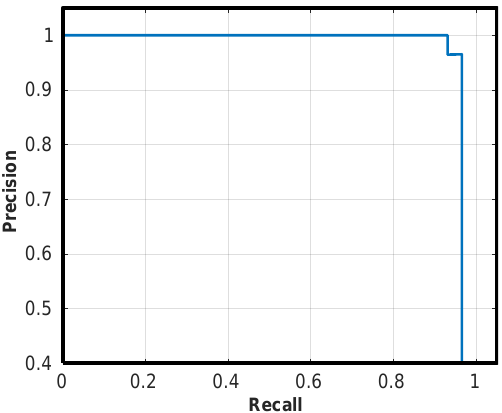
Figure 9. Precision vs. recall curve for St. Maria Valverde